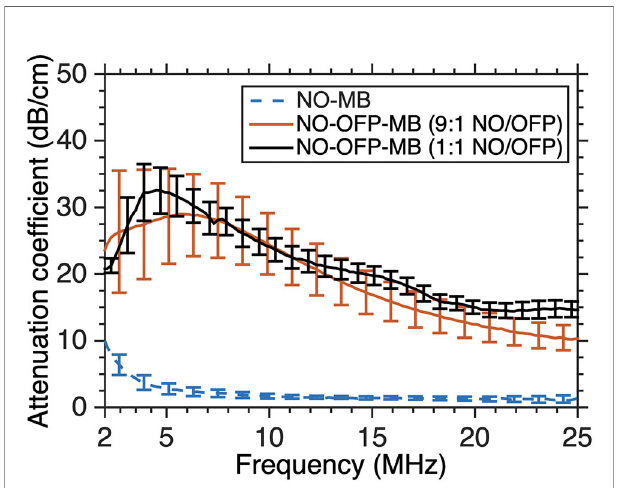
FIGURE 7 | The frequency-dependent attenuation spectra of NO-MB and NO-OFP-MB (9:1 v/v and 1:1 v/v). The mean ± 1 standard deviation is depicted (n = 3 per group). NO-OFP-MB, Nitric oxide and octa fl uoropropane microbubbles.